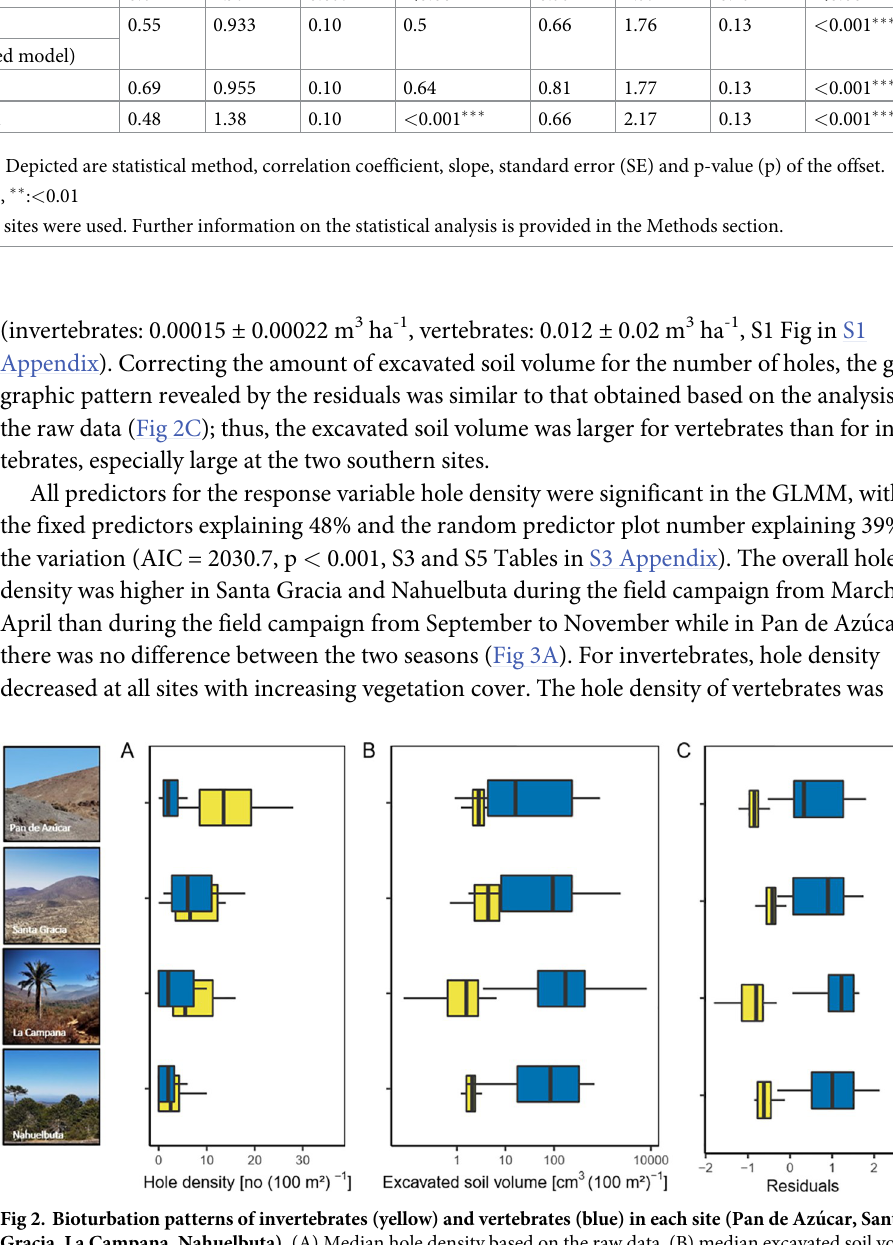
Excavated soil volume and hole density